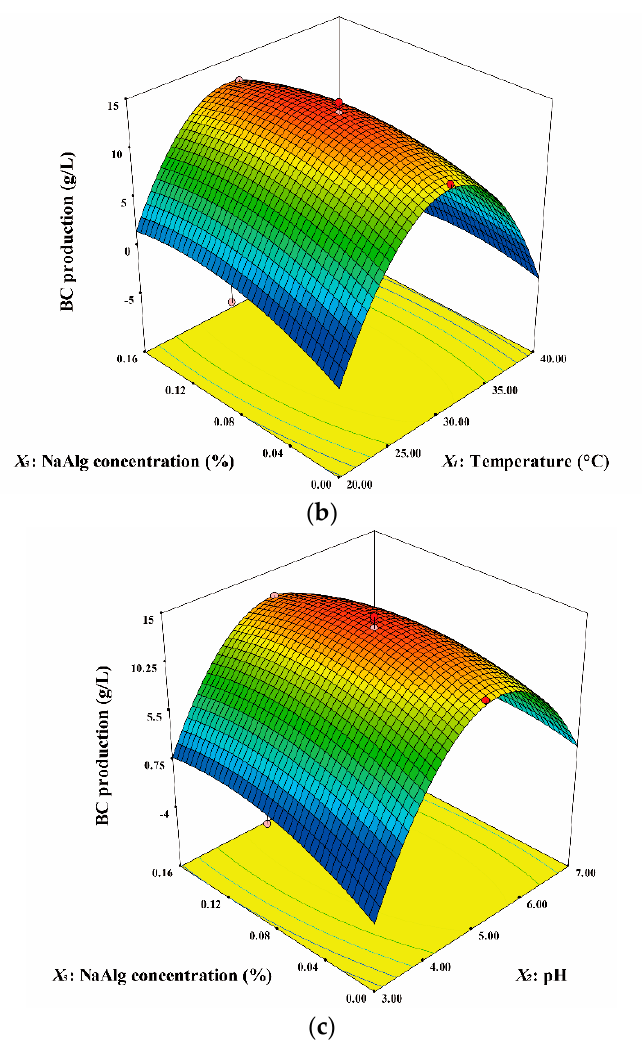
Figure 1. Response surface plots representing the effects of each variable on bacterial cellulose pro- duction. ( a ) Effects of temperature and initial pH; ( b ) effects of temperature and NaAlg concentration; ( c ) effects of initial pH and NaAlg concentration.